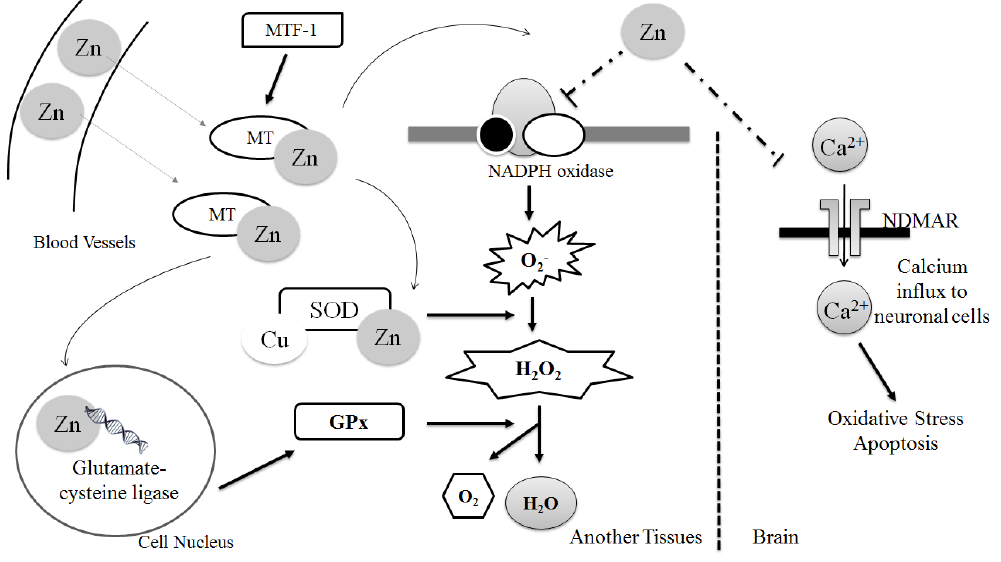
Figure 1. Zinc participation in antioxidant mechanisms. GPx: Glutathione peroxidase; MT: Metallothionein; MTF-1: Metal-responsive transcription factor 1; NADPH: nicotinamide adenine dinucleotide phosphate; NMDAR: N-methyl- D -aspartate receptor; SOD: superoxide dismutase enzyme; Zn: Zinc.